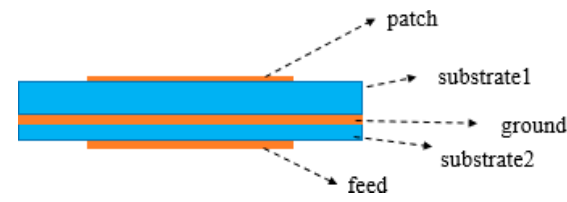
Figure 22. Distribution of antenna units in the array: ( a ) 1 × 2, ( b ) 2 × 2, ( c ) 1 × 4, and ( d ) 2 × 4 arrays.